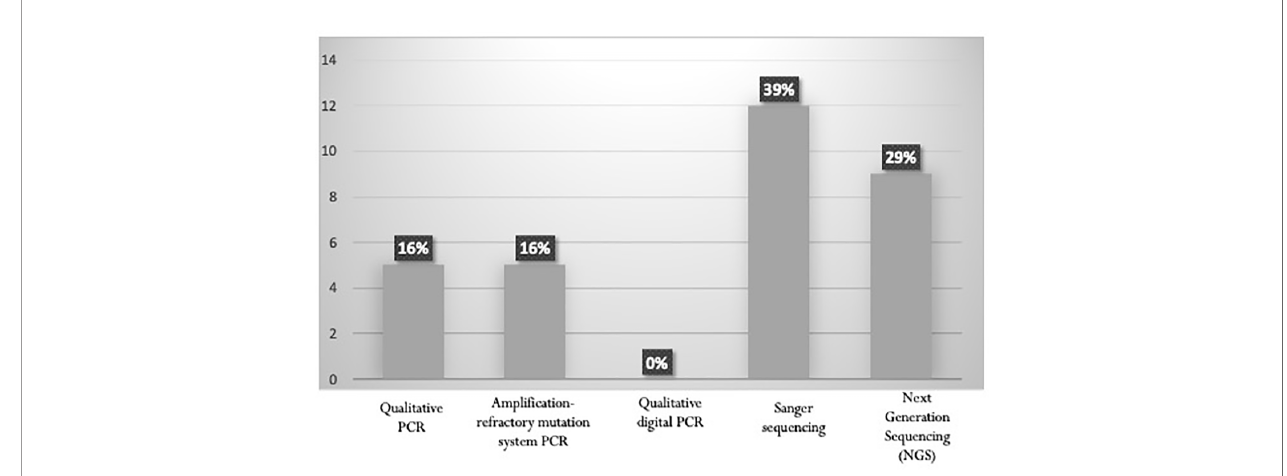
FIGURE 4 | Proportion of Laboratories assessing IDH1/IDH2 mutation status according to ESMO 2020